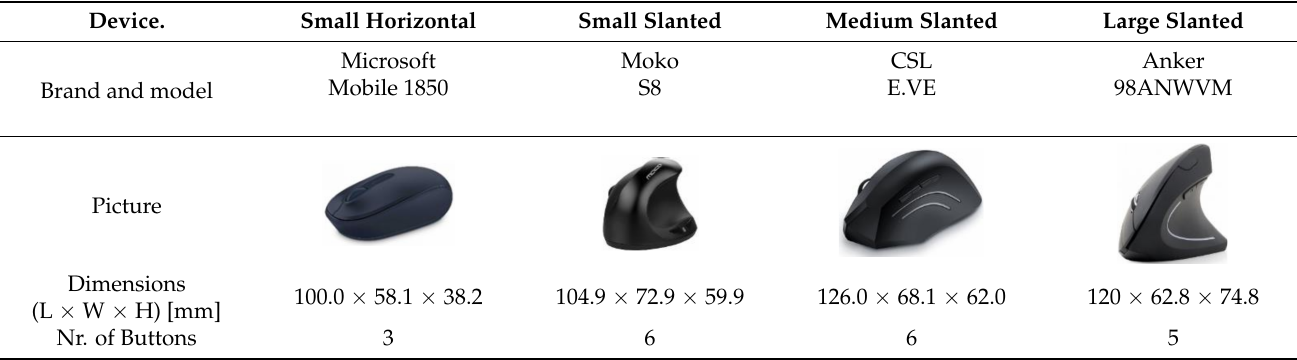
Table 1. Overview of wireless handheld pointing devices (all right-handed) used in the study and under comparison. Device. Small Horizontal Small Slanted Medium Slanted Large Slanted Microsoft Moko CSL Anker Mobile 1850 S8 E.VE 98ANWVM Brand and model